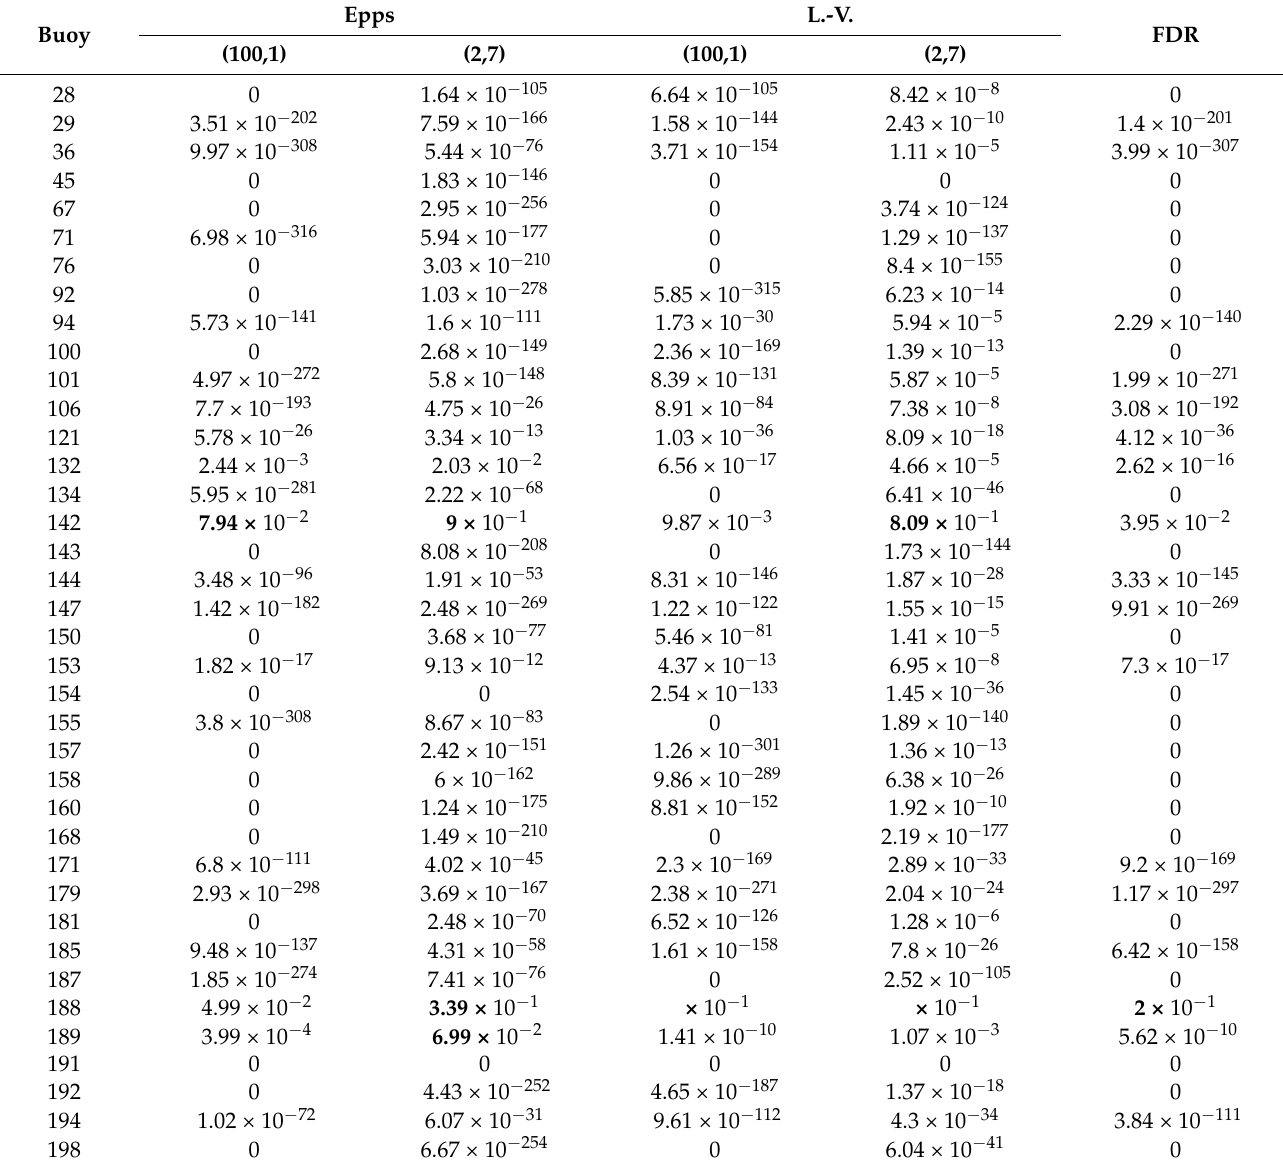
Table 8. FDR adjusted p -value resulting of combining four p -values to apply the random projection test for each buoy. Values larger than 0.05 is highlighted in